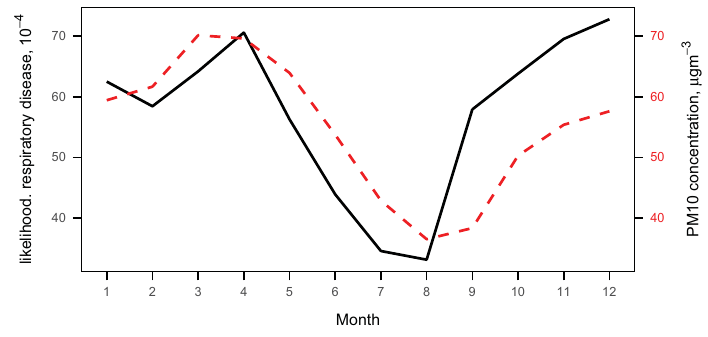
Fig 2. Monthly averages of the likelihood of respiratory disease and the PM 10 concentration. The averages of the likelihood of respiratory disease by month (multiplied by 10 4 ) are represented in black line (values are denoted on vertical axis on the left). The averages of the PM 10 concentration by month are displayed in red dotted lines (values are denoted on vertical axis on the right).